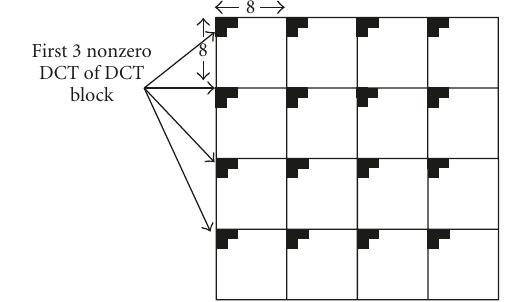
Figure 3: WLF-max motion vector composition algorithm.